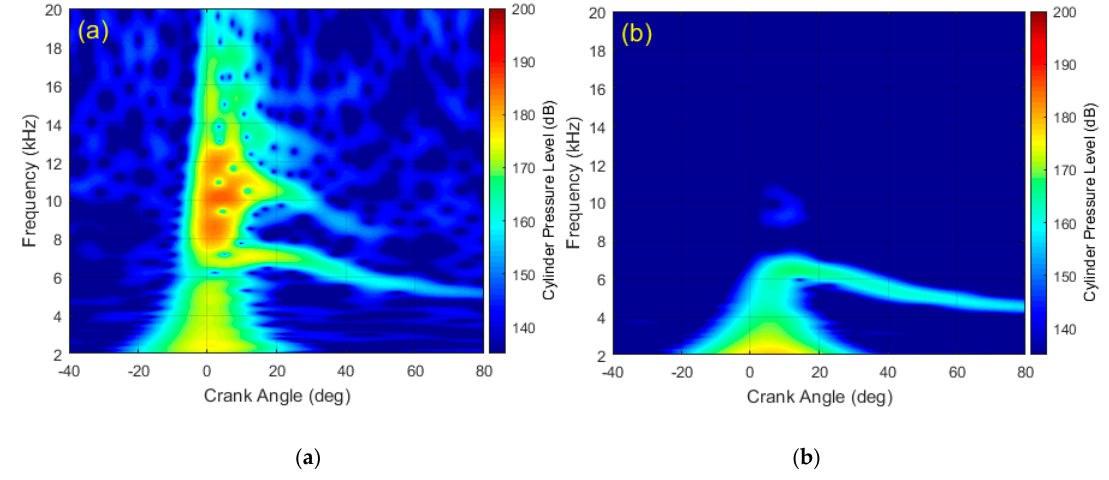
Figure 19. Time-frequency distribution (TFD) of different load: ( a ) 100% load; ( b ) 50% load.